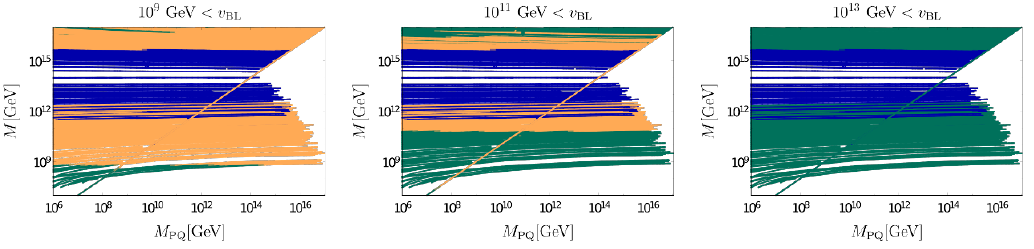
Figure 9 . Intermediate scales M PQ and M BL and GUT-scale M U for Model 3.2 for di(cid:11)erent threshold corrections. The curves in blue are excluded by gauge-mediated proton decay limits, the curves in green by the limit on the B-L breaking scale. We have considered three di(cid:11)erent ranges of allowed B-L breaking scales. The threshold corrections are randomised in the following way: all scalars take masses among the values f 1 ; 1 ; 5 g times the corresponding threshold scale, where we 5 have taken care not to make proton decay mediating scalars light. We have reduced the range of possible threshold corrections since the bigger range did not yield enough viable